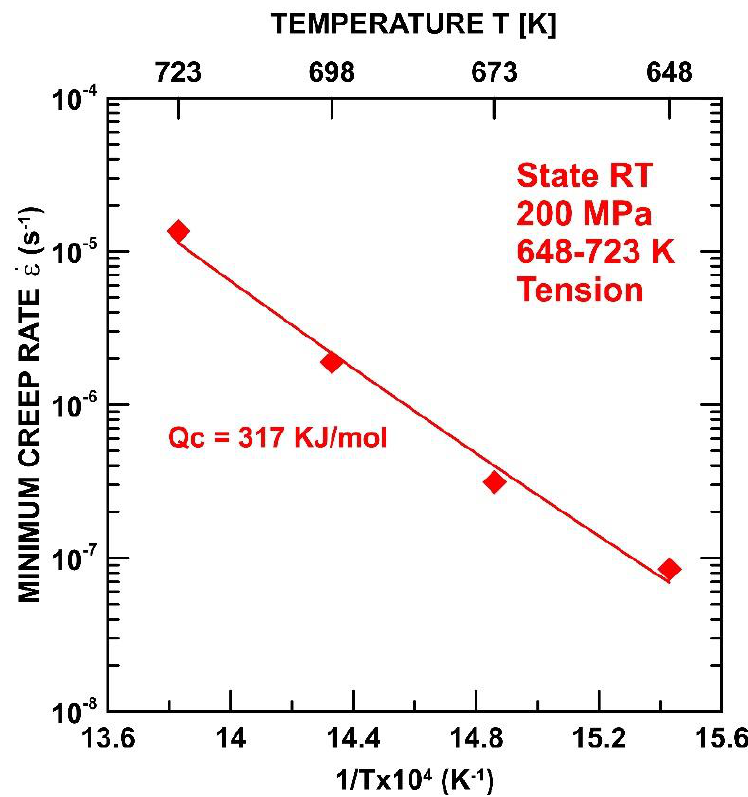
Figure 5. Activation energy for (steady-state) creep of RT state as a function of temperature.